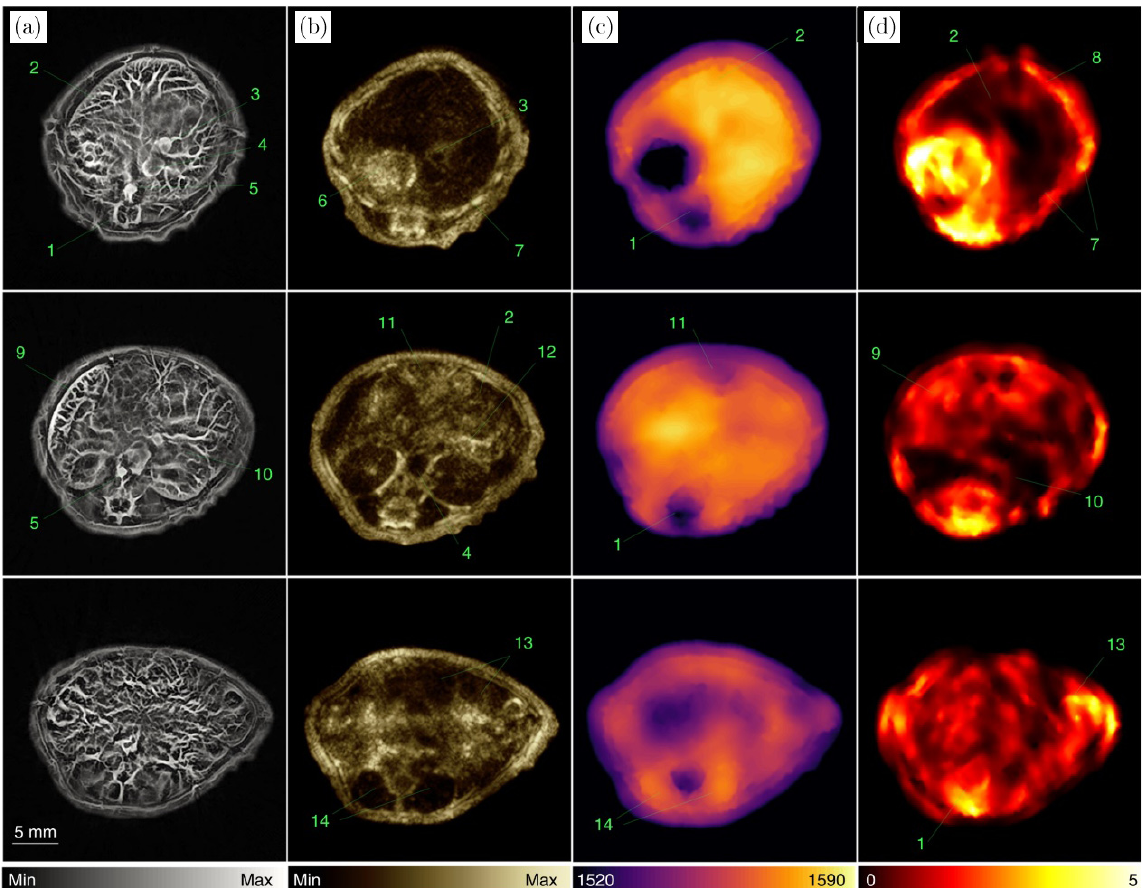
Fig. 12. USCT enhanced PACT imaging. (a) Three representative PA images of the cross-sections of a mouse. (b) Corresponding re°ection-mode ultrasound images. (c) and (d) Corresponding transmission-mode ultrasound images showing the distribution of the SOS and acoustic attenuation, respectively. 1: spinal cord; 2: liver; 3: vena porta; 4: vena cava; 5: aorta; 6: stomach; 7: ribs; 8: